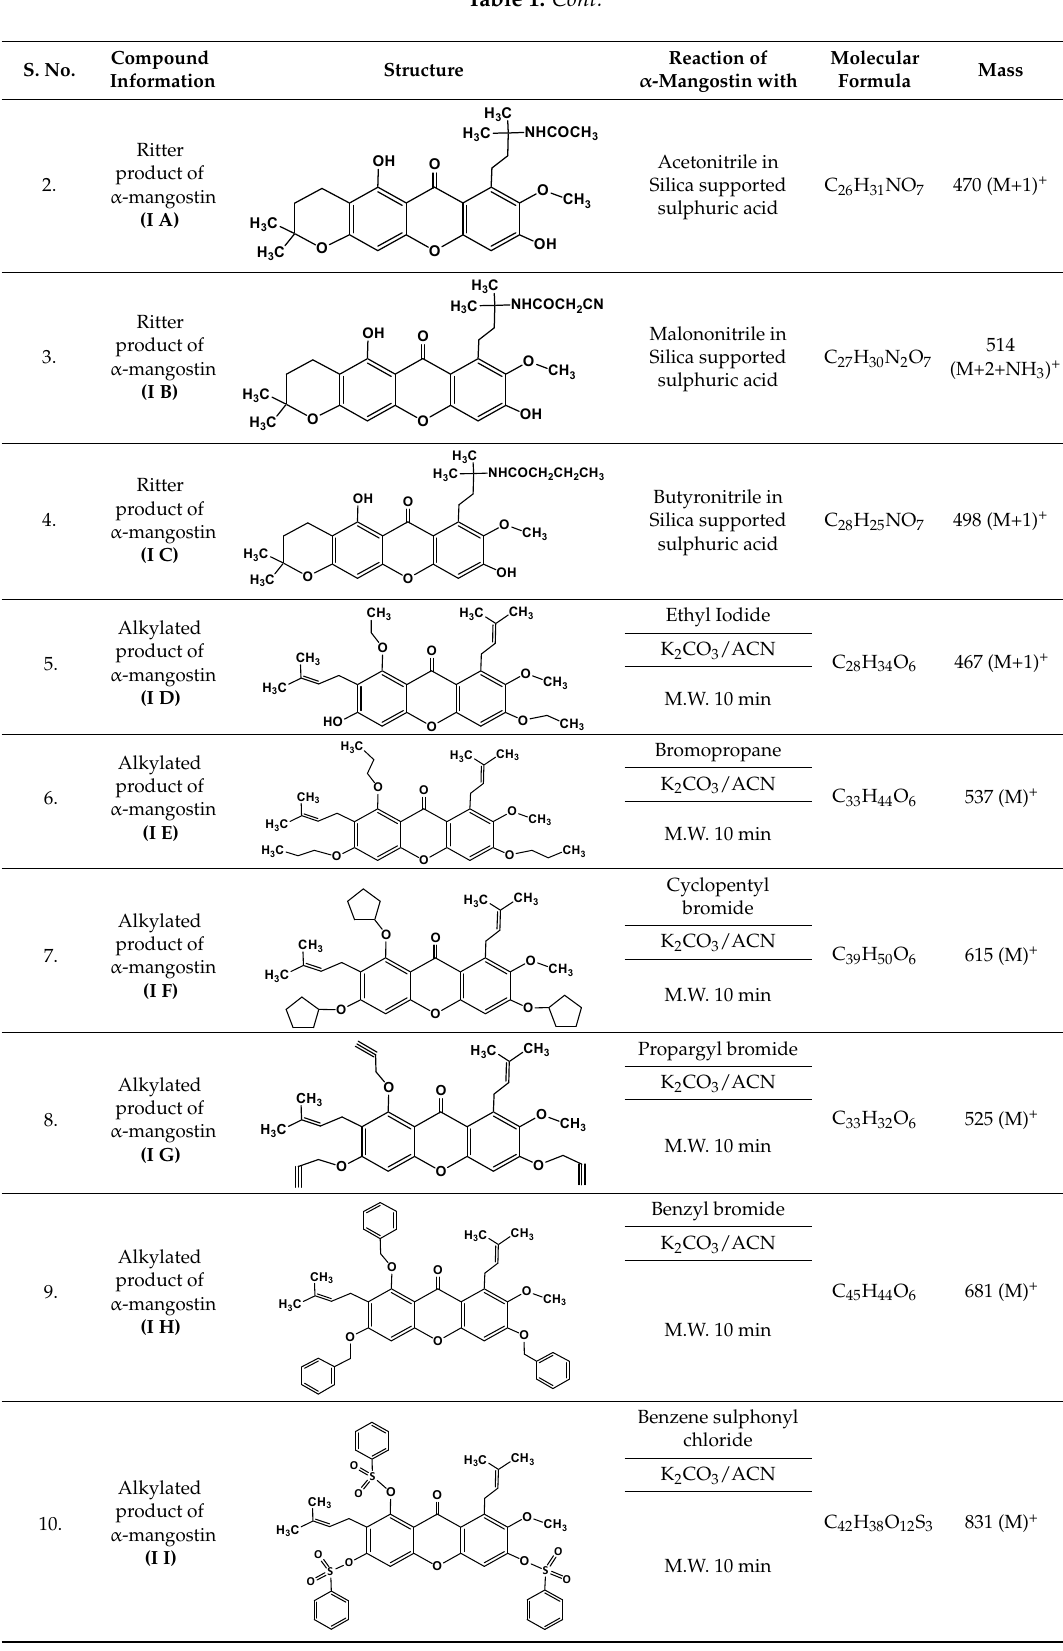
4 of 14 Figure 2. Reaction scheme leading to different derivatives. The basic core structure xanthone (anthraquinone) was conserved intact while the functional iso-prenyl and phenolic hydroxy groups were subjected to semi-synthetic modification. Twelve different semi-synthetic derivatives were obtained (Table 1), each containing new key moieties that were evaluated to detect the anti-microbial activity against various bacterial and fungal cultures. ( I D ), the alkylated product of α -mangostin with ethyl iodide, was found to be a di-alkylated product. All other alkylations using the exact same reaction conditions reported in the table resulted in tri-alkylated products. In the Ritter reaction, the addition of acetonitrile, followed by intra-molecular addition of –OH to isoprene unit gave ether (or) pyran ring structures. Addition of acetonitrile is followed by hydration to produce amide. This reaction is general for all the nitrile reaction products studied ( I A to I C ). Compound ID, reaction of α -mangostin with ethyl iodide, produced mainly the di-alkylated product, probably due to the possibility of ether cleavage of reaction product HI during the reaction. All other alkylation reactions carried out